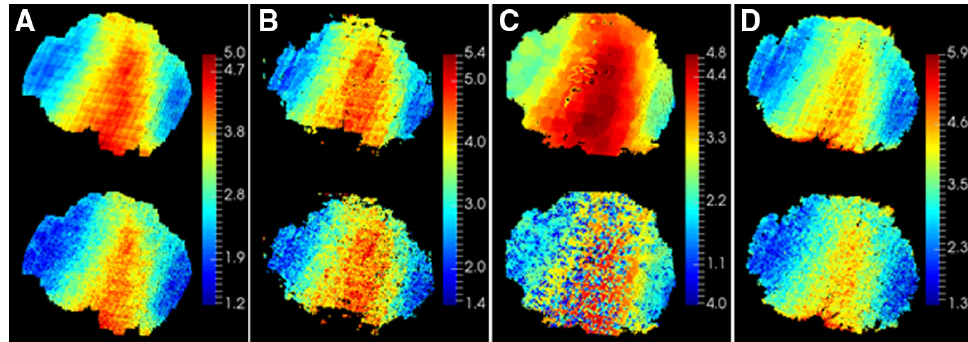
Figure 5: Thickness values (mm) of lateral cartilage projected along the z-axis. Top row: original segmentations as input data, bottom row: noisy segmentations as input data. (A) Nearest neighbor. (B) Surface normals. (C) Local thickness. (D) Field lines.